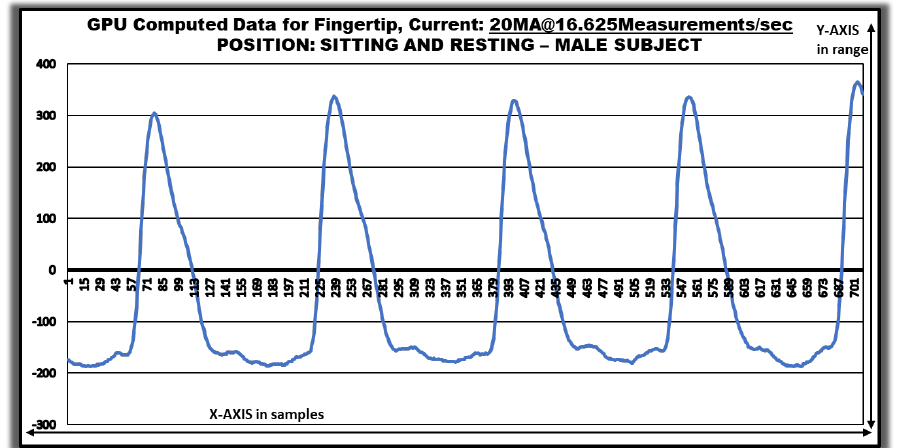
Figure 10. GPU-Computed Data using Fingertip: Observation Set B.